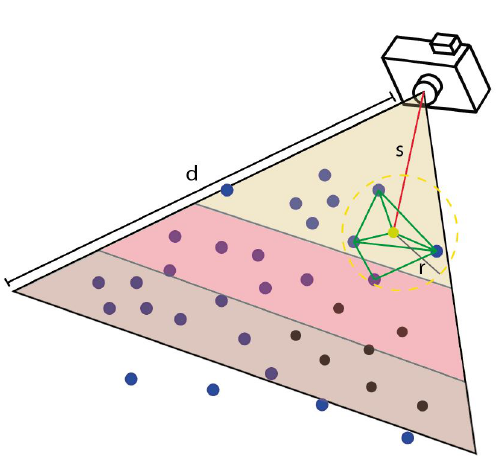
Figure 5. Occlusion detection on the point cloud. The target point (yellow) and their neighbors create a surface (green) to detect the occluded points